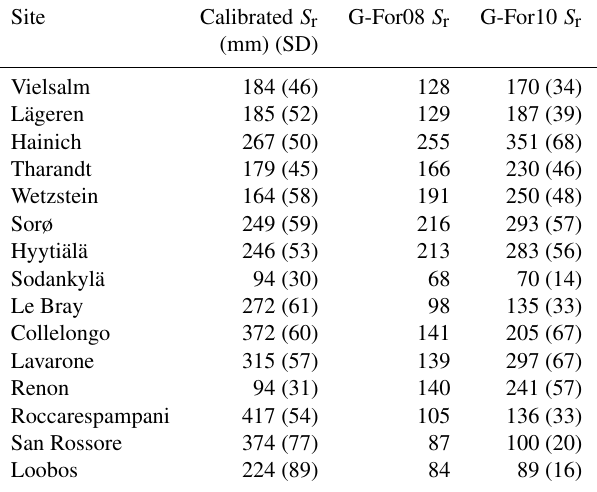
Table 4. Calibrated and modeled S r obtained at each site. For cali- brated values, the S r value is the median of the parameter values in the simulations with KGE AVG equal to or greater than the 95th per- centile. The value in parentheses is the standard deviation of these parameter values. For S r estimates obtained with G-For10, this ta- ble shows the values calculated with unperturbed parameters, and the value given in parentheses is the standard deviation of results obtained in the uncertainty